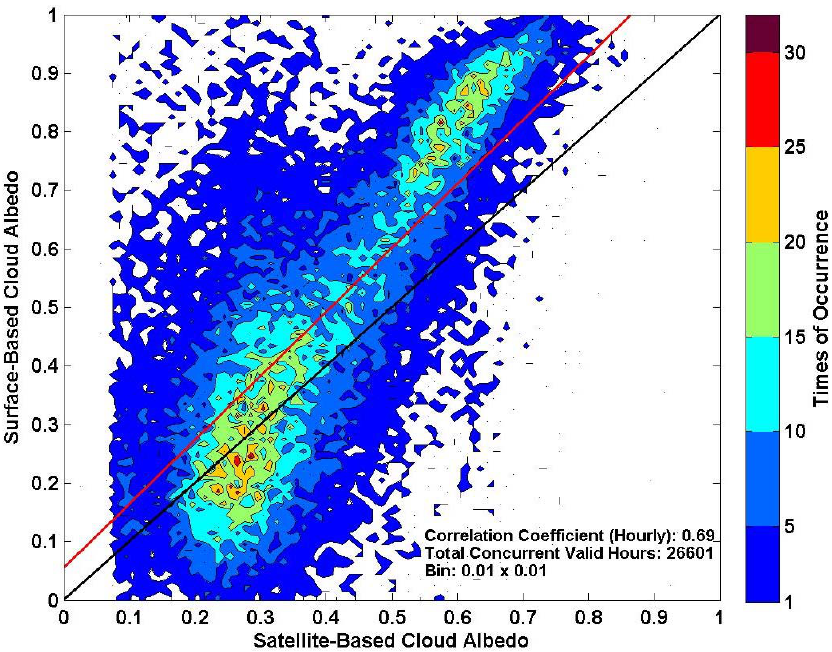
Fig. 1. Comparison of the surface-based cloud albedo with those derived from the GOES satellite. The red and black lines represent the linear fit to all the data points and perfect match,